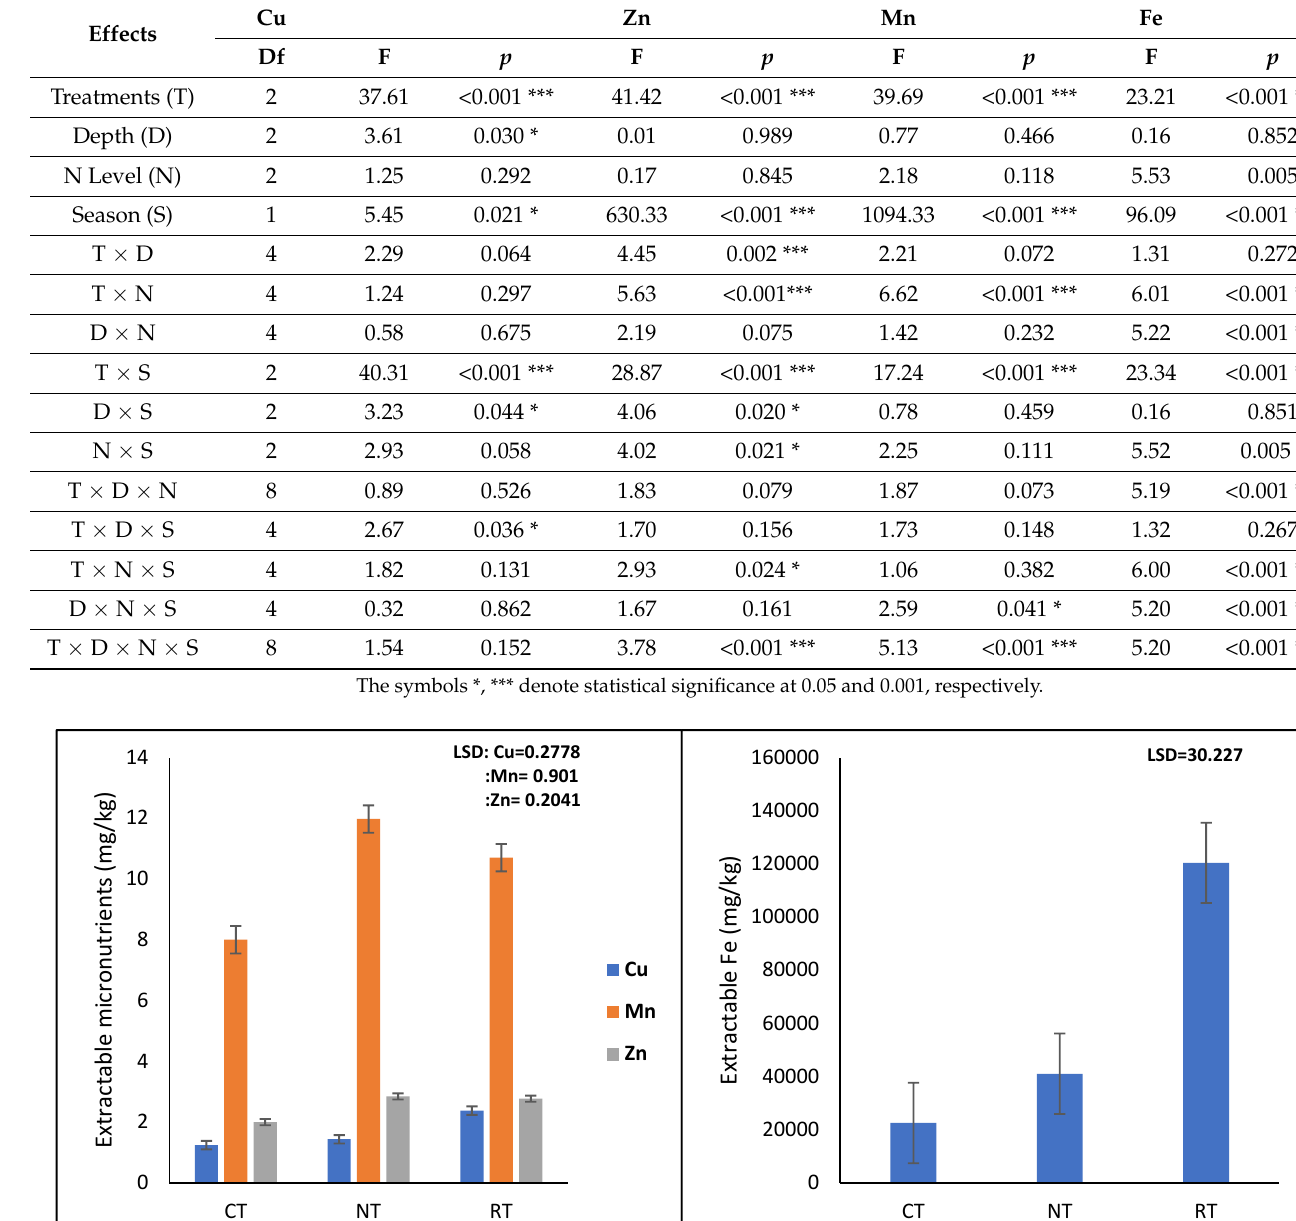
Table 3. ANOVA results of the effect of tillage treatments [no-till (NT), rotational tillage (RT), and conventional tillage (CT)], depth (0–10, 10–20, and 20–30 cm), N-levels (0, 100, 200 kg/ha), sampling time (April 2019 and August 2019) and their interaction on extractable copper (Cu), manganese (Mn), iron (Fe), and zinc (Zn). p F p F p F p